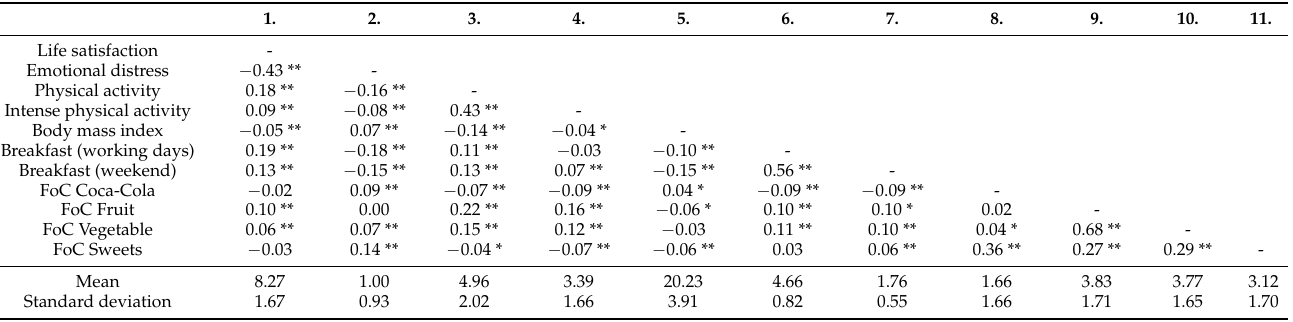
Table 2. Descriptive Statistics and Correlations.